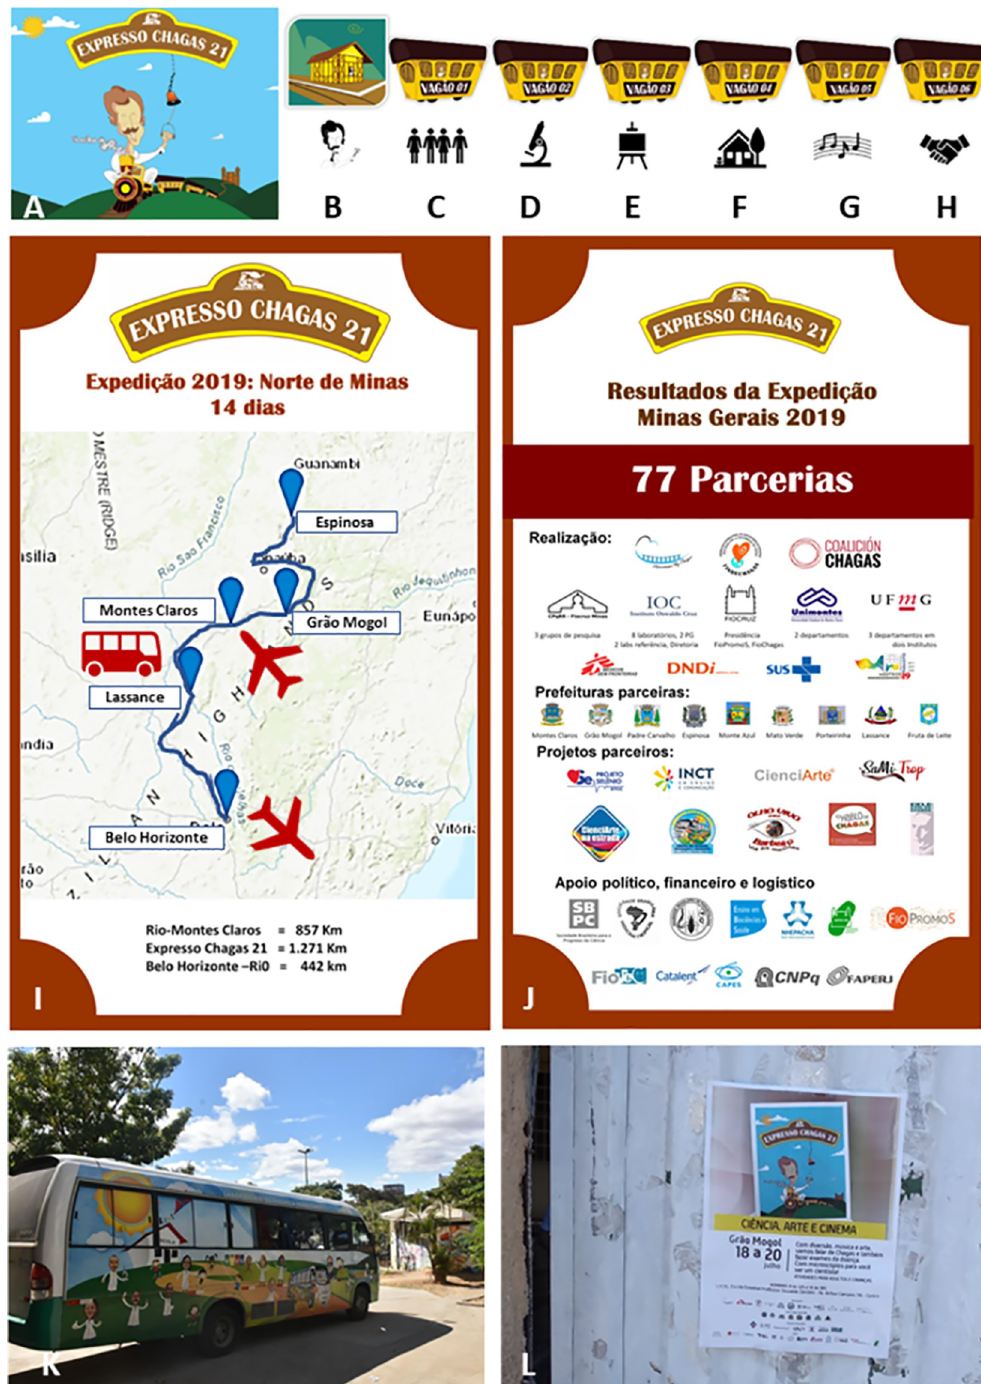
Fig 1. Materials and images of the Chagas Express XXI expedition to the northeast of Minas Gerais, Brazil, in winter vacation, July 2019. Art concept of Chagas Express XXI created by Erik J. Costa (A—J). The main pamphlet (A), the entry station (B) the successive wagons (C,D,E,F,G,H) and the general template of the banners (I,J) prepared as part of the exhibition composing expedition; the travel route and vehicles (prepared over a map that was in public domain - https:// store.usgs.gov/map-locator) (I) and partnership logos of the projects network, cooperating institutions and municipalities in the presentation of activities (J); mobile laboratory in the “Science on the Road” project bus that merged the team (K); local poster to publicize scheduled activities